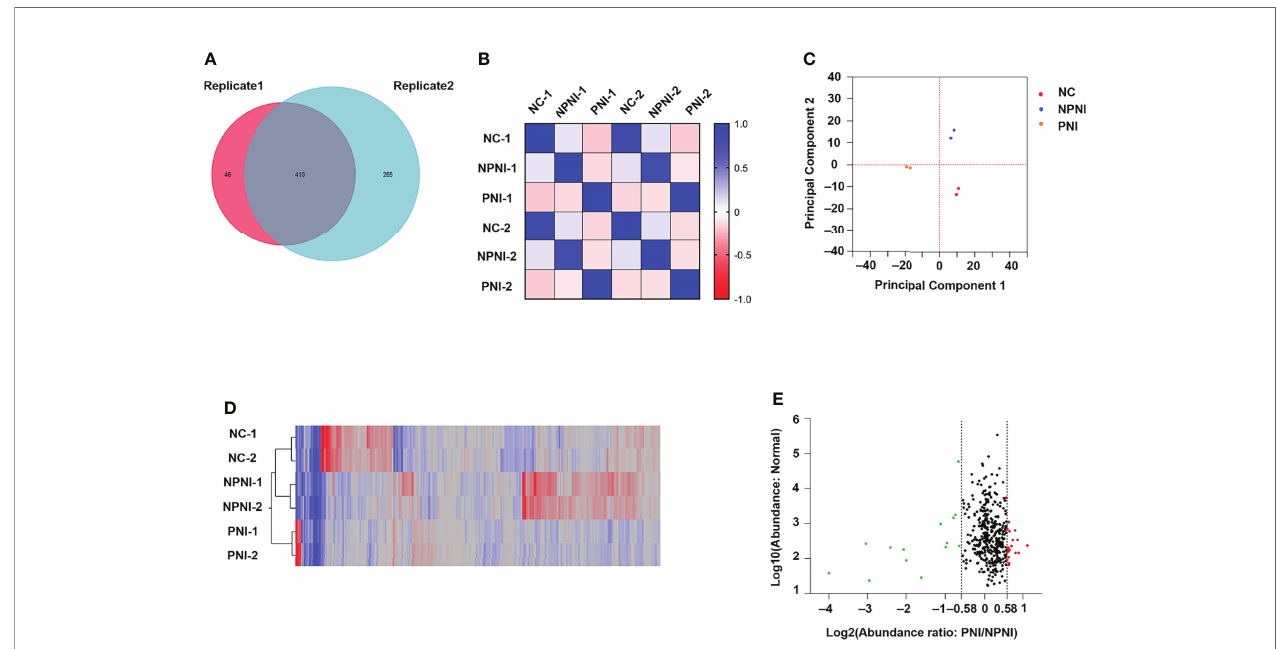
FIGURE 3 | Characteristics of DEPs in EVs between the PNI and NPNI groups. (A) Venn diagram of proteins identi fi ed in duplicate quantitative TMT experiments, showing the overlap of 410 differentially expressed proteins (DEPs) identi fi ed in two technical replicates. (B) Correlation matrix showing the protein abundance correlations between the normal, NPNI, and PNI groups. (C) Principal component analysis of proteins identi fi ed in quantitative TMT experiments. (D) Heatmap showing the relationship between protein expression levels in each sample mapped using the 410 (DEPs) identi fi ed in two technical replicates of quantitative TMT experiments. (E) Scatter plot showing the distribution of upregulated (red dots) and downregulated (green dots) DEPs between the NPNI and PNI